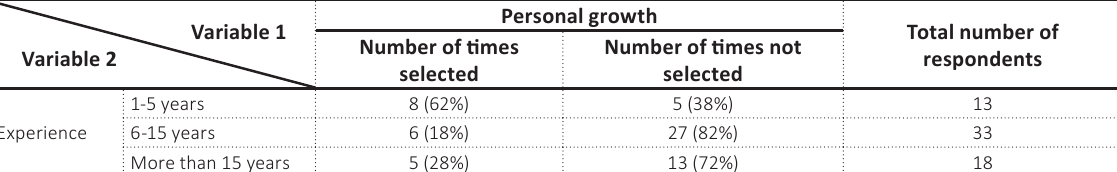
Relationship with manager Table 6. Effect of experience on personal growth as a motivator